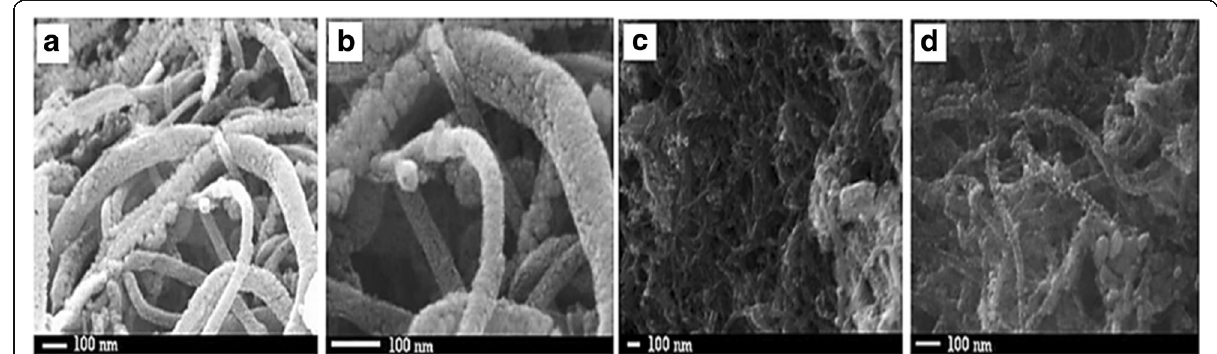
Fig. 9 FESEM images of CNT/SnO2 composite support ( a , b ) and PtRu/SnO2/CNT composite electrocatalyst ( c , d )